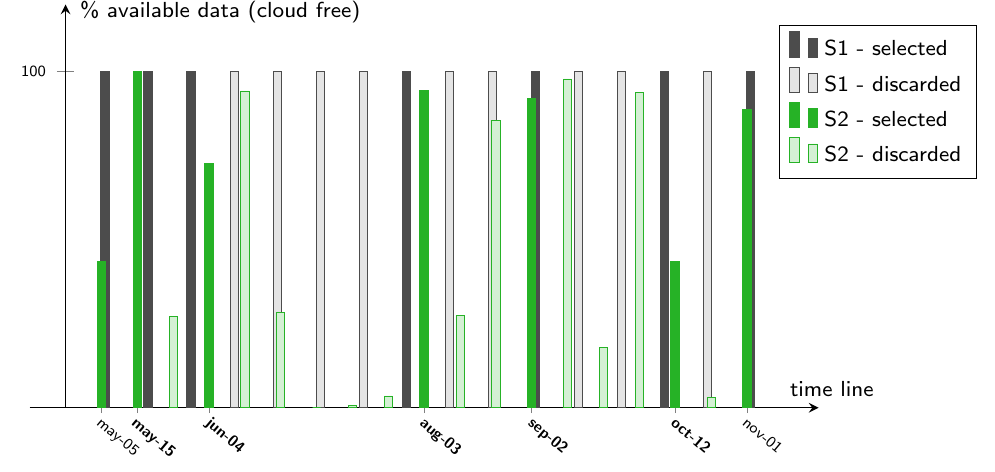
Figure 1. Available S1 (black) and S2 (green) images over the period of interest. The bar height indicates the fraction of usable data. Solid bars mark selected images; boldface dates mark test